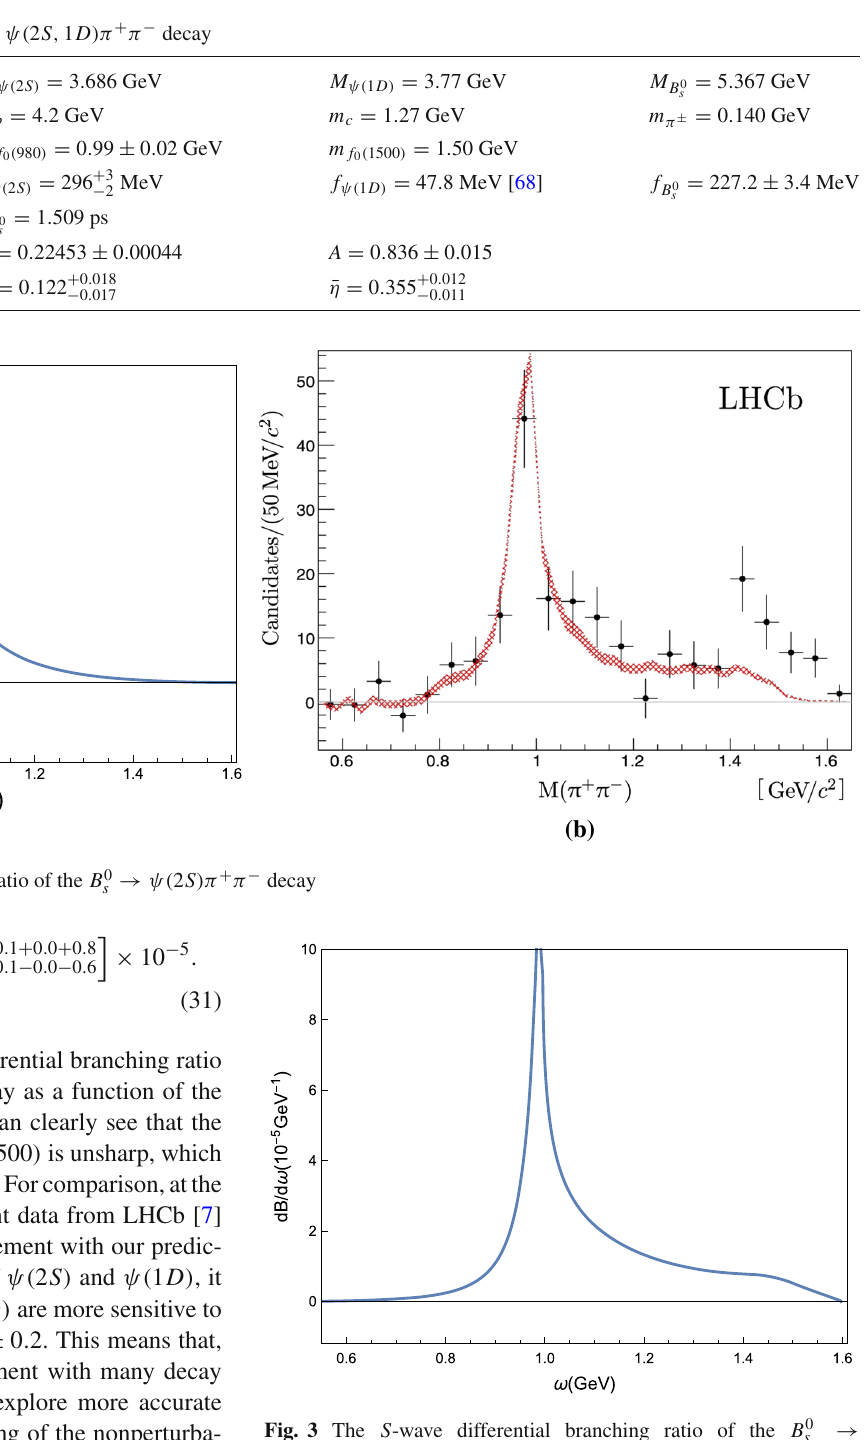
Fig. 3 The S -wave differential branching ratio of the B 0 s → ψ( 1 D )π + π −